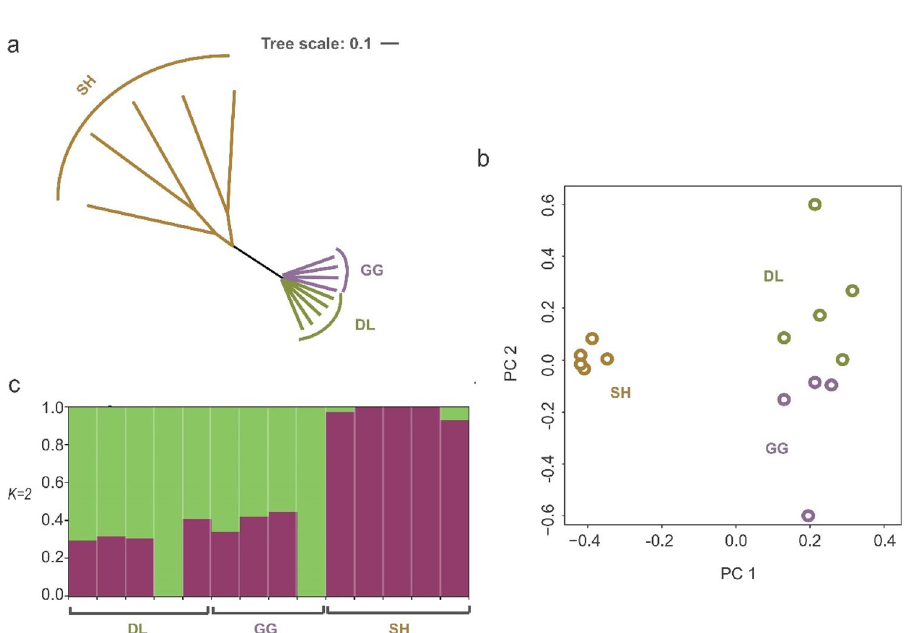
Figure 3. Population structure in Amur ide ecotypes. ( a ) Maximum-likelihood phylogenetic tree. ( b ) Principal component analysis, PC 1 against PC 2. ( c ) Population structure. Colors in each fragment represent the proportion of K = 2 ancestral populations assigned to individual